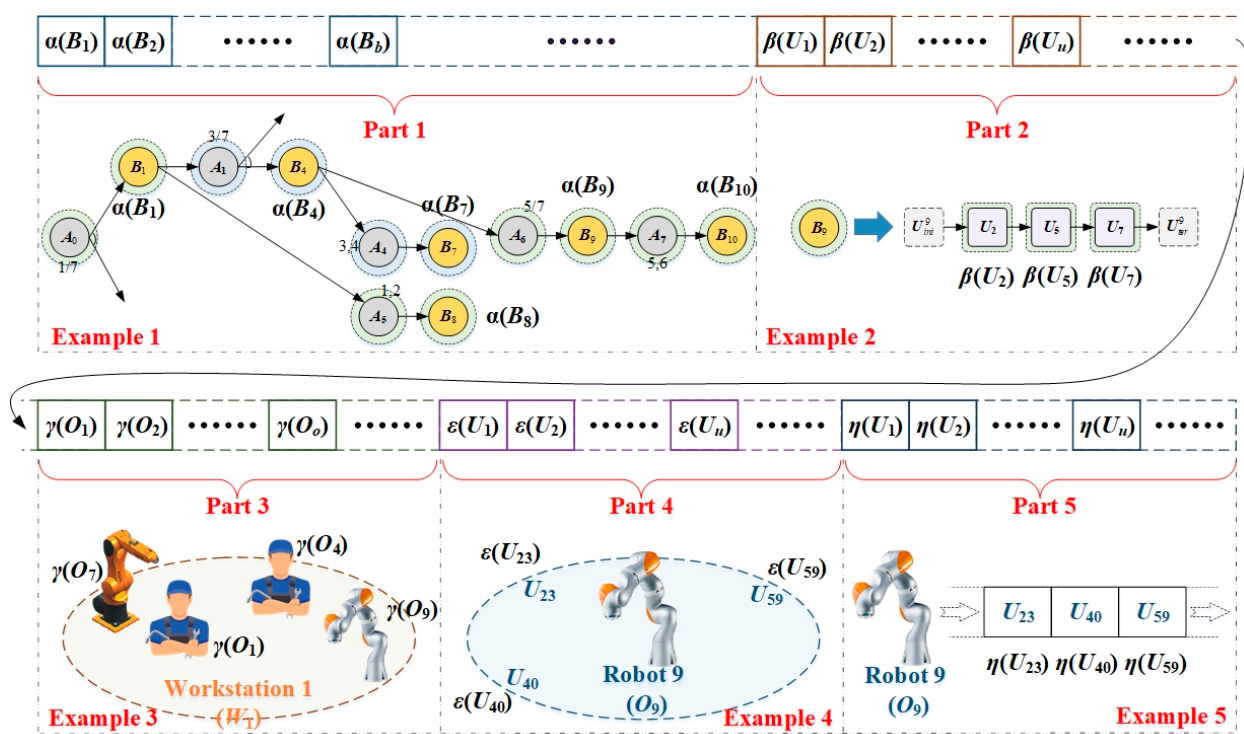
Figure 5. The encoding scheme for solving the D-HRDLB